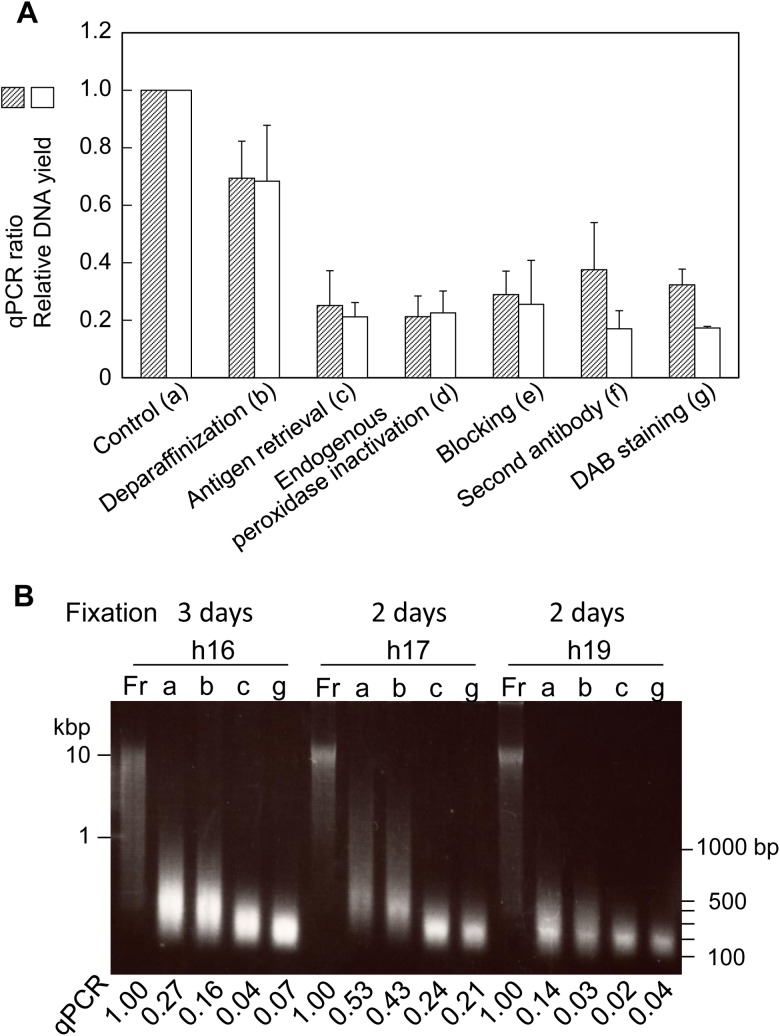
DNA quality and quantity during the course of IHC staining of FFPE thin sections.(A) The DNA qPCR ratio and relative DNA yield were expressed using FFPE thin sections before the start of IHC used as the control. The IHC procedure was divided into 6 steps. Four FFPE samples (h16 to h19) were used for human hepatocyte marker immunostaining. The qPCR value and DNA yield relative to the matched control were calculated, and the mean values of 4 samples were compared among the 6 steps. Control DNA was prepared directly from matched FFPE thin sections according to our modified RecoverAll protocol with additional heat treatment. (B) Agarose gel (0.8%) electrophoresis of 3 representative sets (h16, h17 and h19) of matched DNA samples (500 ng/lane). Fr, frozen tissue DNA; a, b, c, g, DNAs as shown in (A).